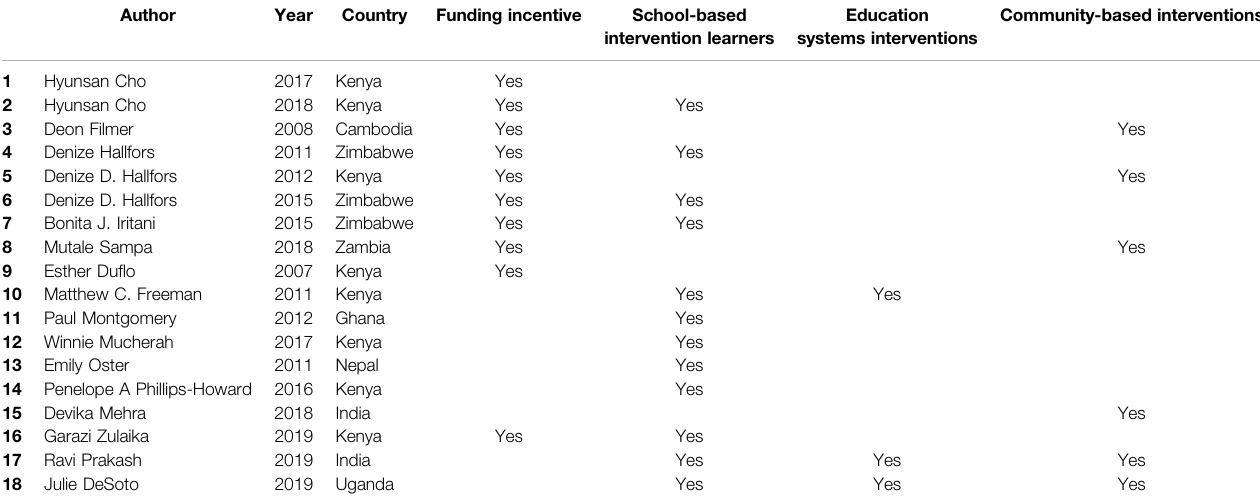
TABLE 1 | Overview of types of interventions covered by included